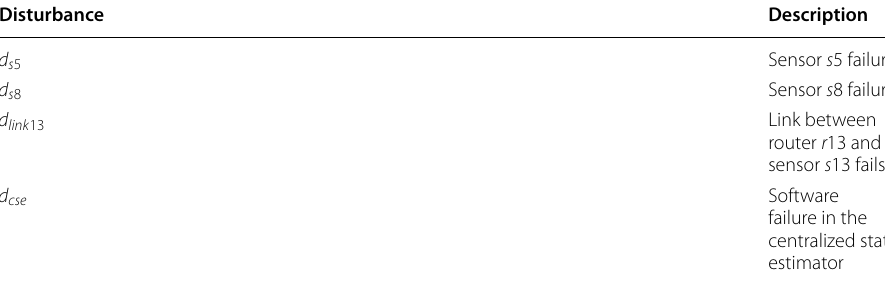
Table 1 Description of the ICT disturbances